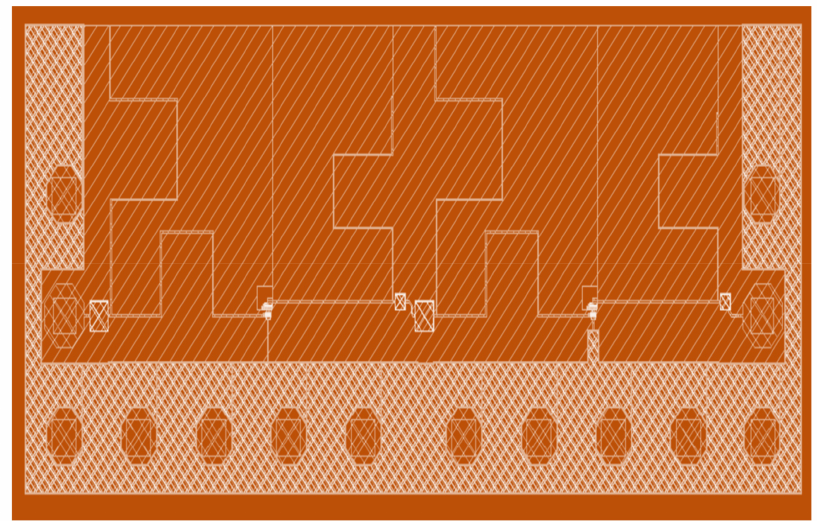
Figure 11. EM Layout of the two-stage